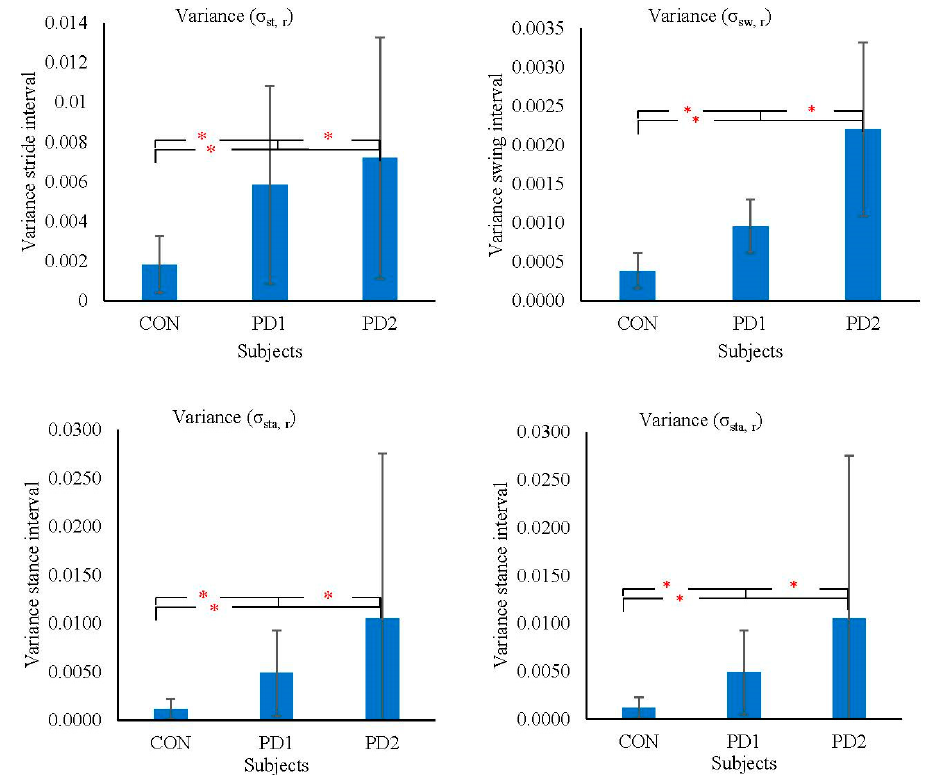
Figure 4. Bar chart showing the variance in stride, swing, stance, and double-support intervals for CON, PD1, and PD2 subjects, respectively (* p (significance) < 0.05, ns (nonsignificant). Table 3. Comparison between the mean (±SD) and variance (±SD) of gait parameters for CON, PD1, and PD2 groups, and the p -values for statistical significance.